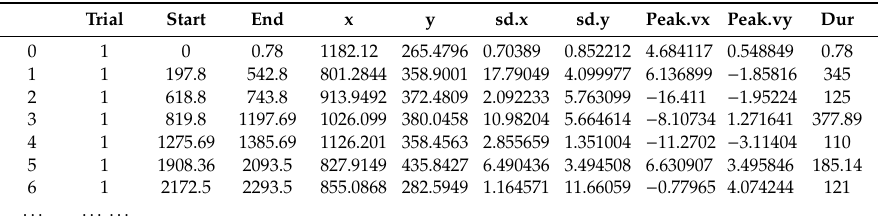
Table 2. Example of results from processing clean data with R to obtain the gaze plot and heat